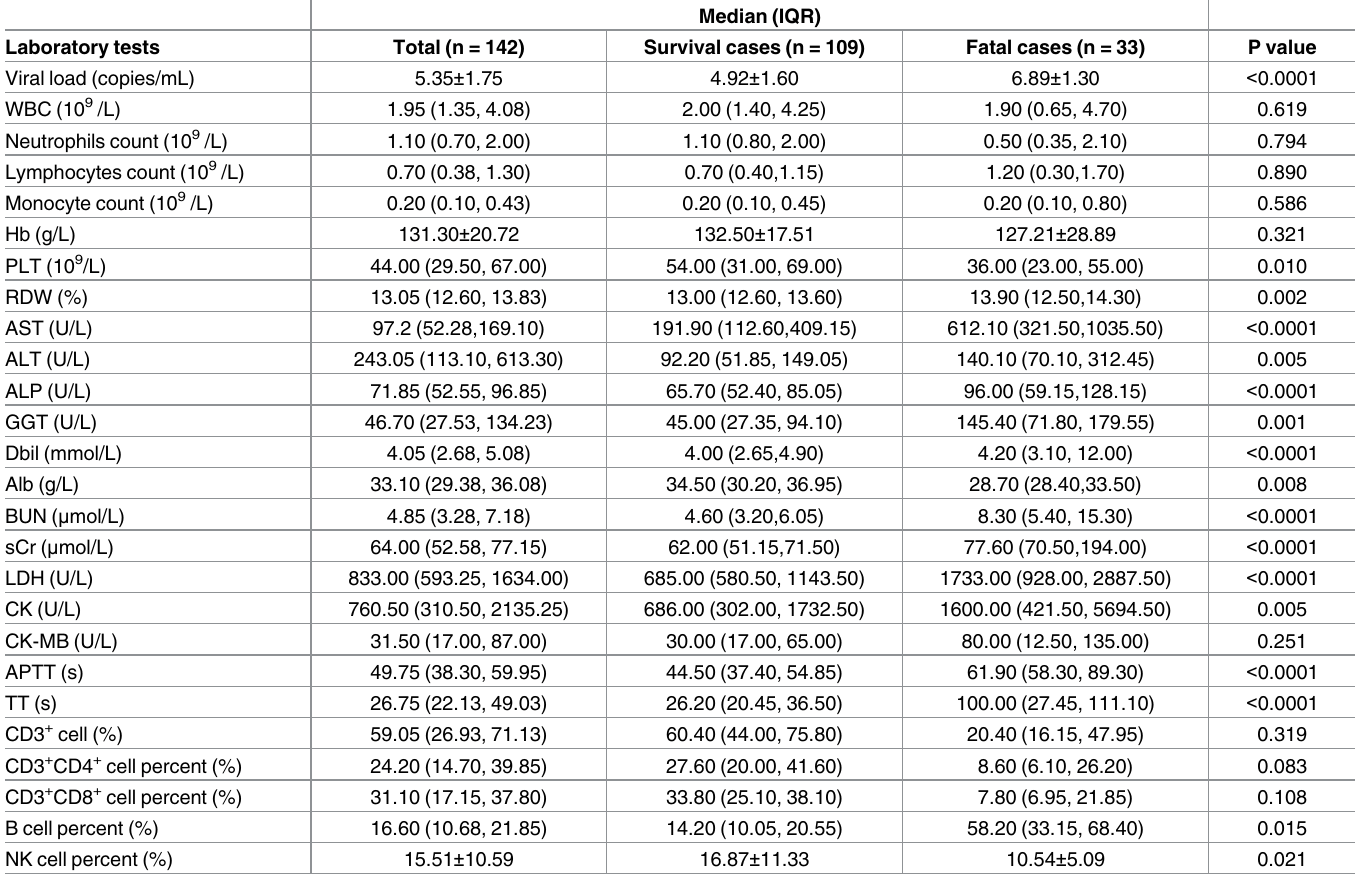
Table 2. Laboratory features of hospitalized case-patients with confirmed severefever with thrombocytopenia syndrome by outcome on